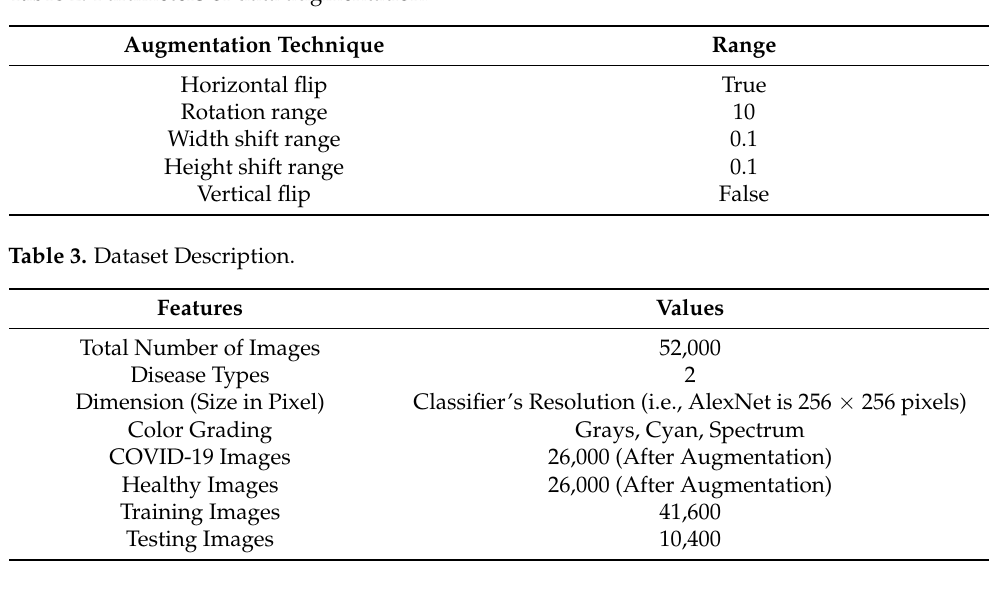
Table 2. Parameters of data augmentation.